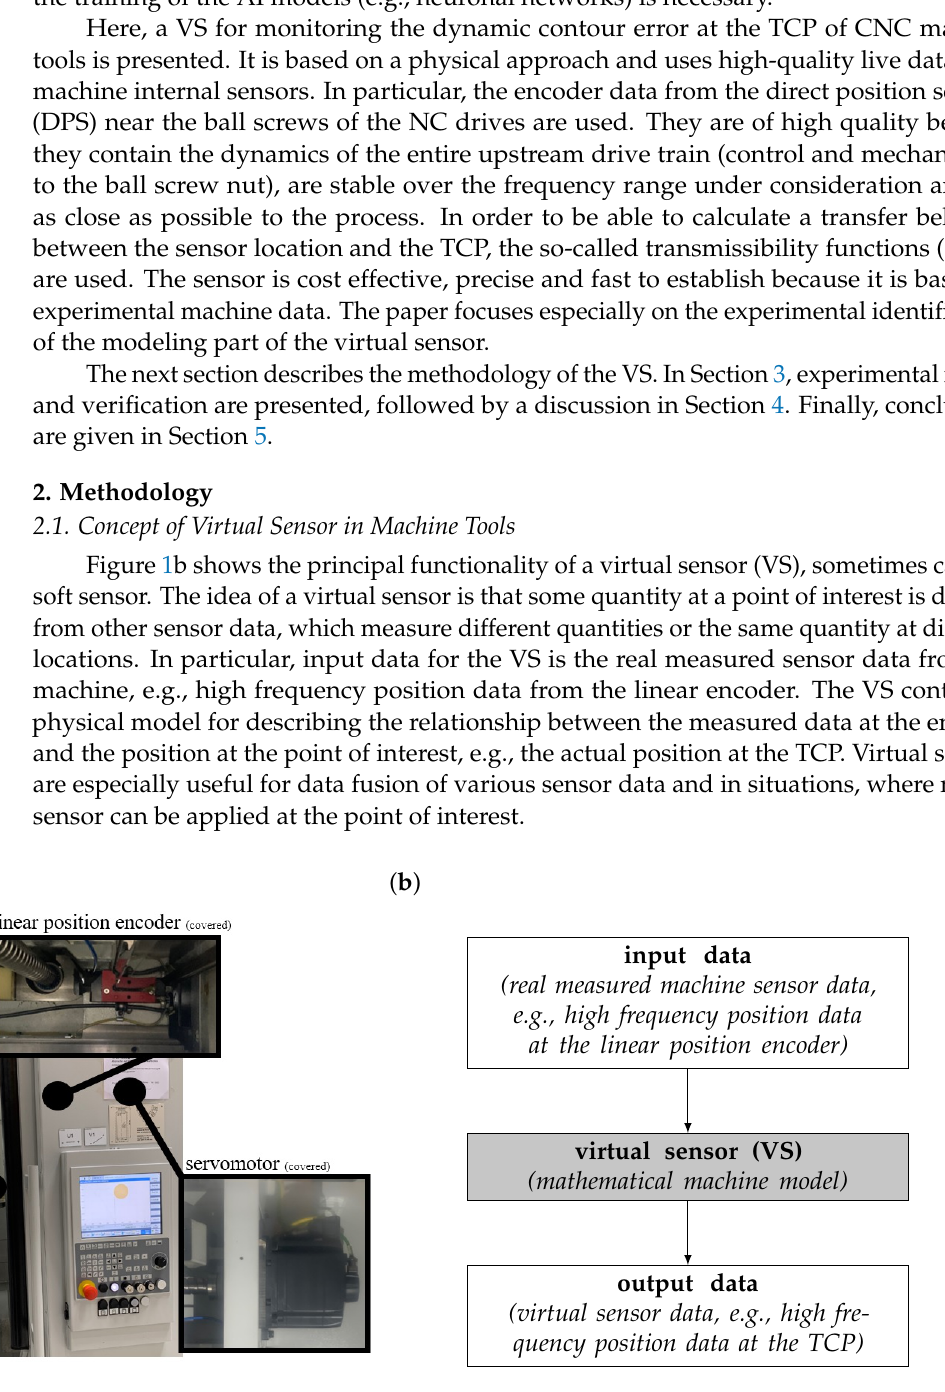
Figure 1. ( a ) Overview about the relevant dynamical parts of a milling machine axis. ( b ) Principal functionality of a virtual